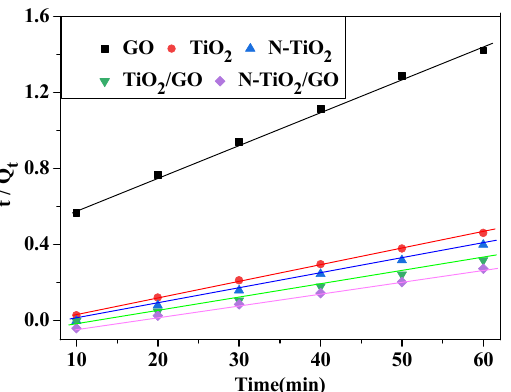
Figure 8. Pseudo-second-order dynamics of different samples for RhB adsorption.